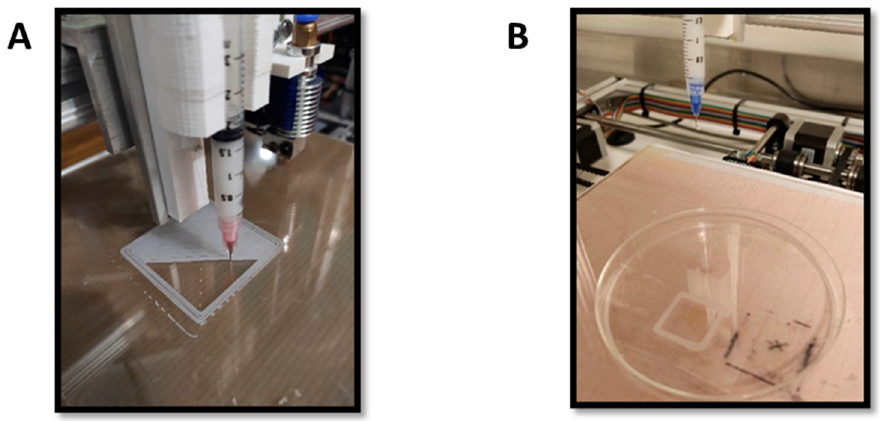
Figure 4. ( A ) First deposition test, directly over the PVC bed and ( B ) One of the squares printed, into a Petri plate, 20 mm side.